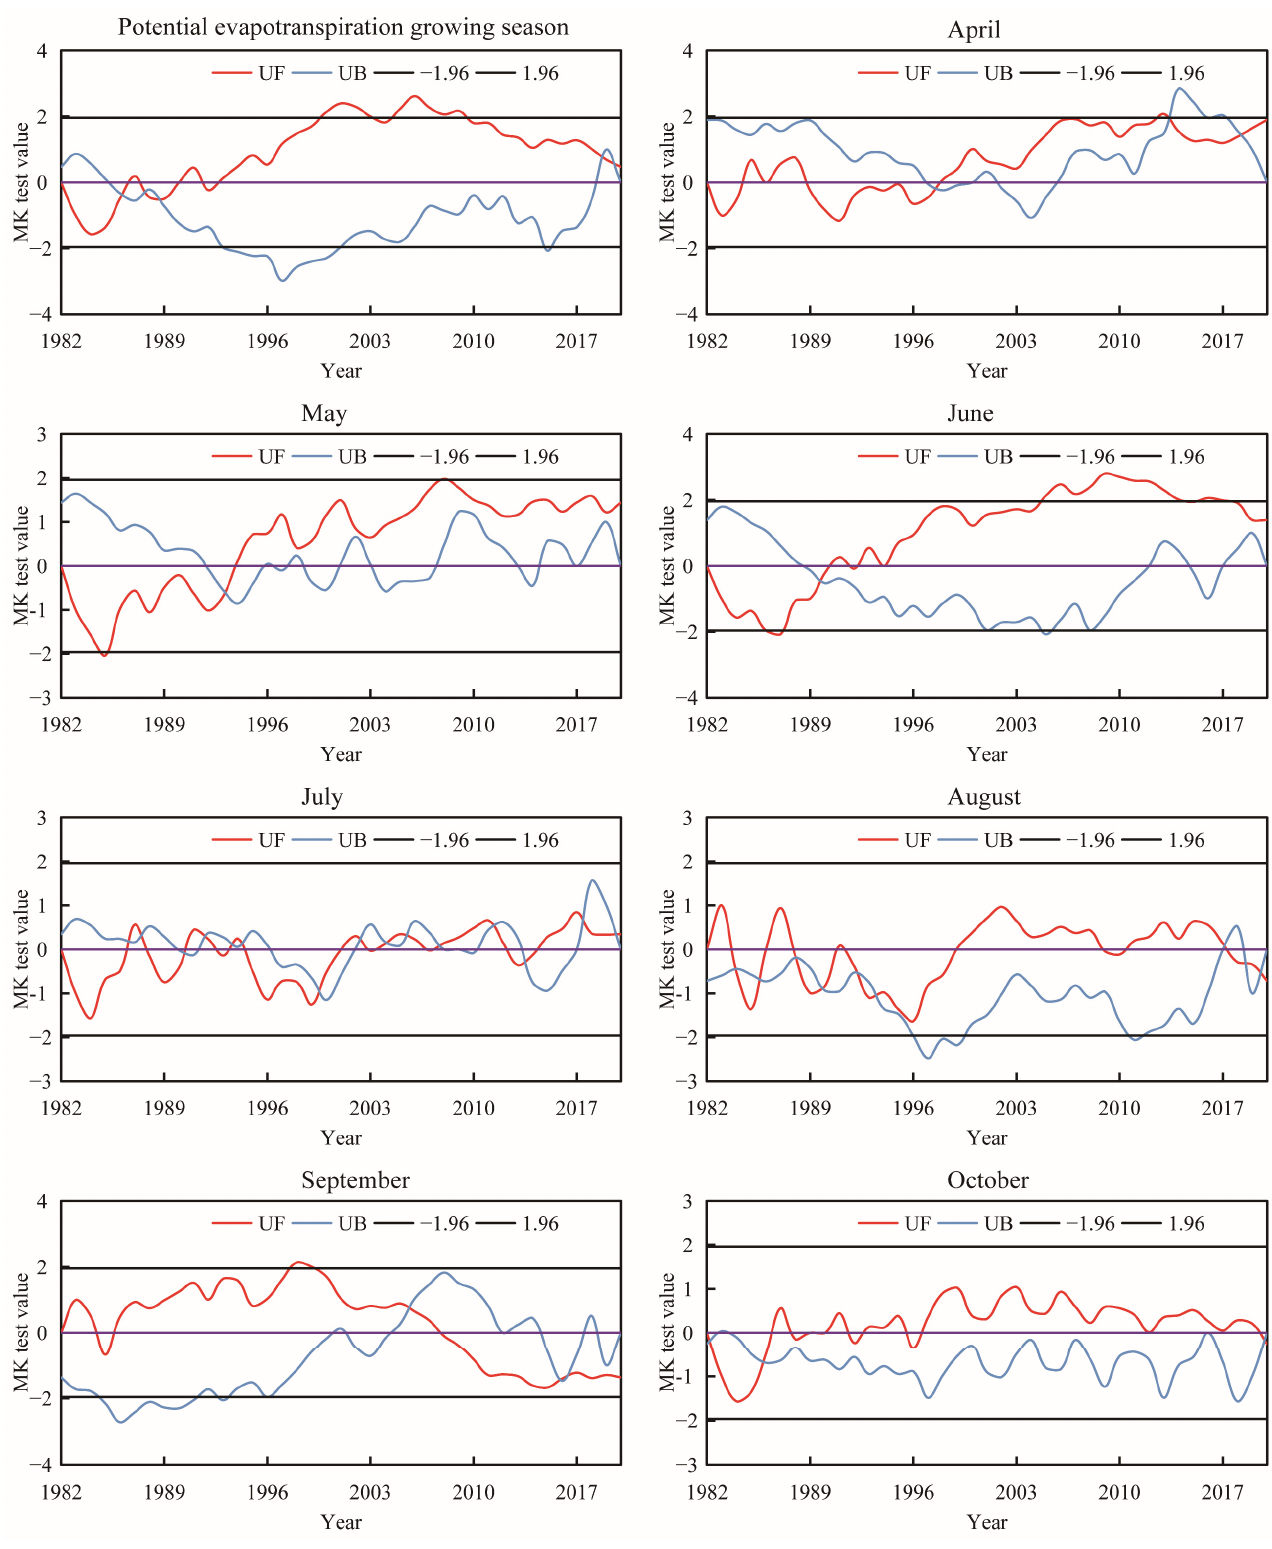
Figure 4. Monthly MK test values of potential evaporation during the growing season .